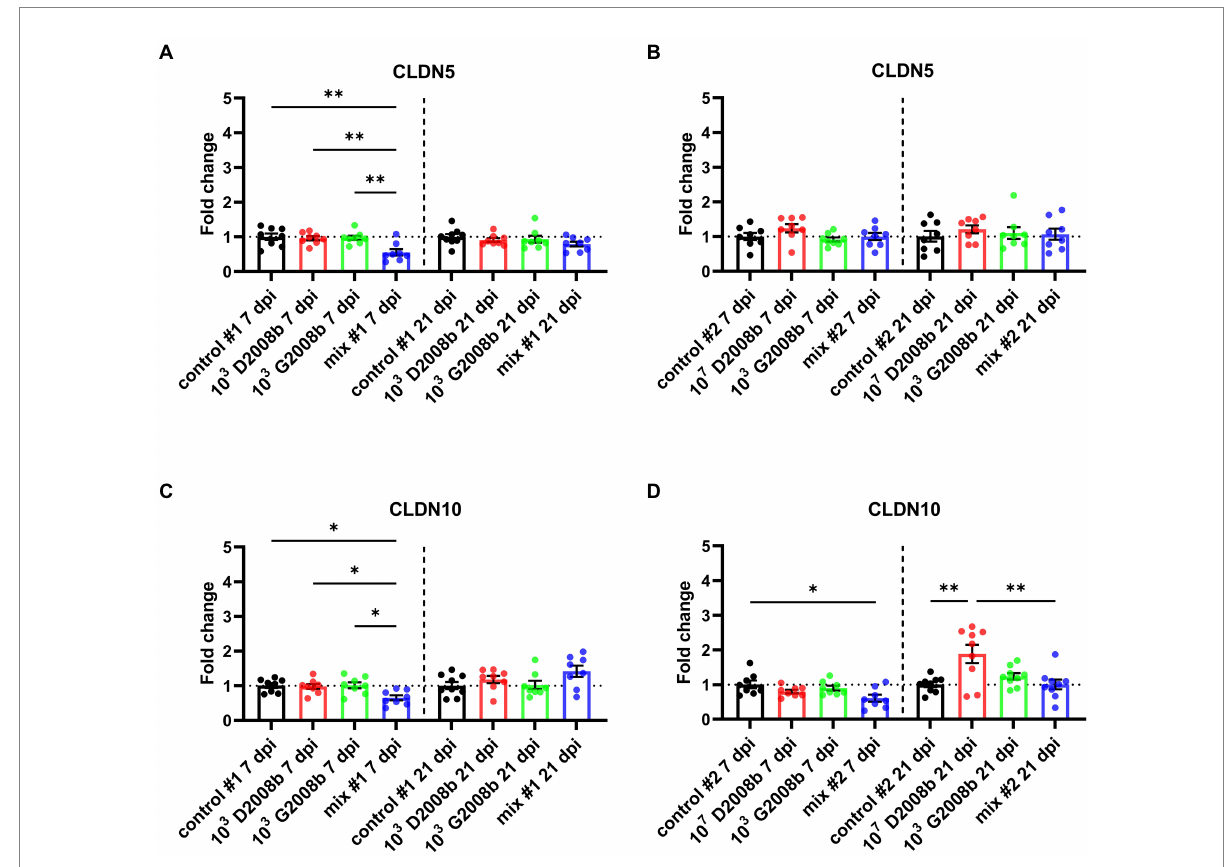
FIGURE 6 Relative gene expression of CLDN5 (A,B) and CLDN10 (C,D) in ileal tissue for rooms 1 and 2, respectively, at 7 dpi and 21 dpi. Dots correspond to the protein expression level normalized to two reference genes, RPL32 and β -actin , and to the mean value of the control group. Vertical bars represent mean values ± SEM. ANOVA test followed by Tukey’s multiple comparison tests were used to analyze statistical differences between chicken groups within the same time point. * and ** indicate p <0.05 and p <0.01